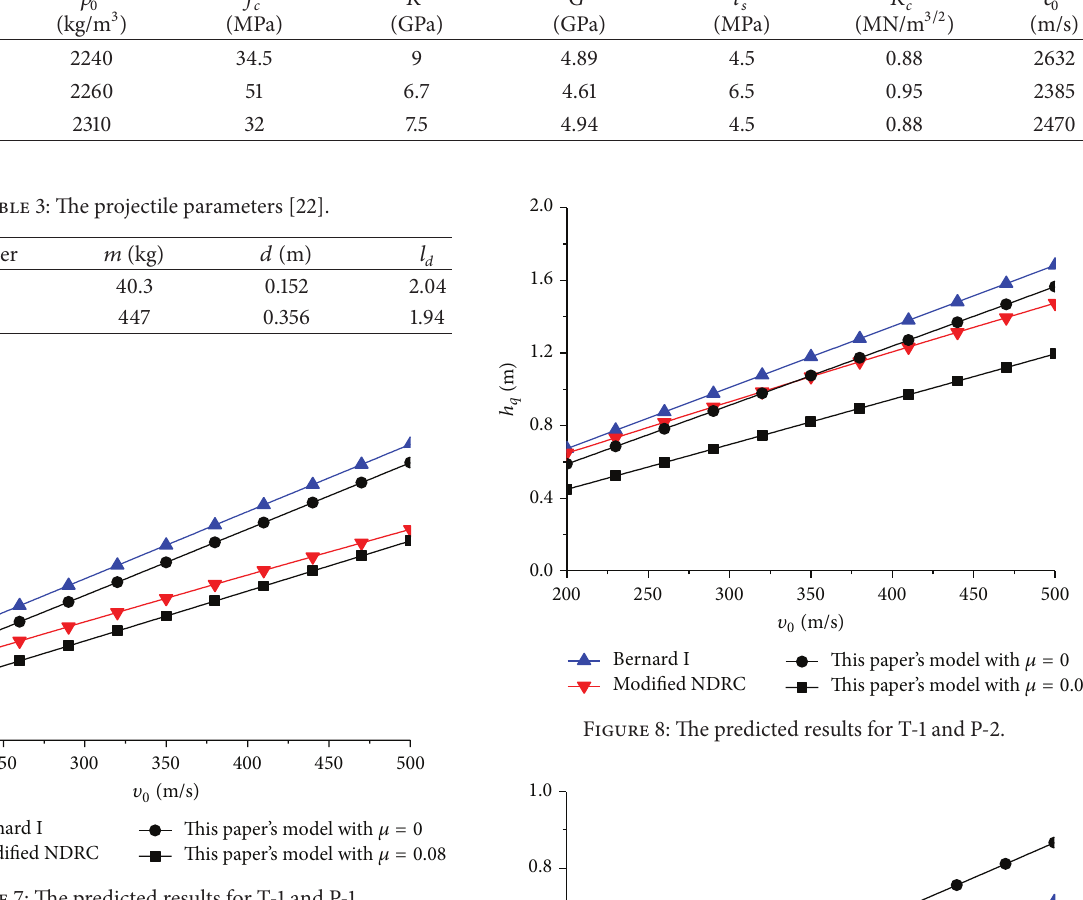
Figure 7: The predicted results for T-1 and P-1.